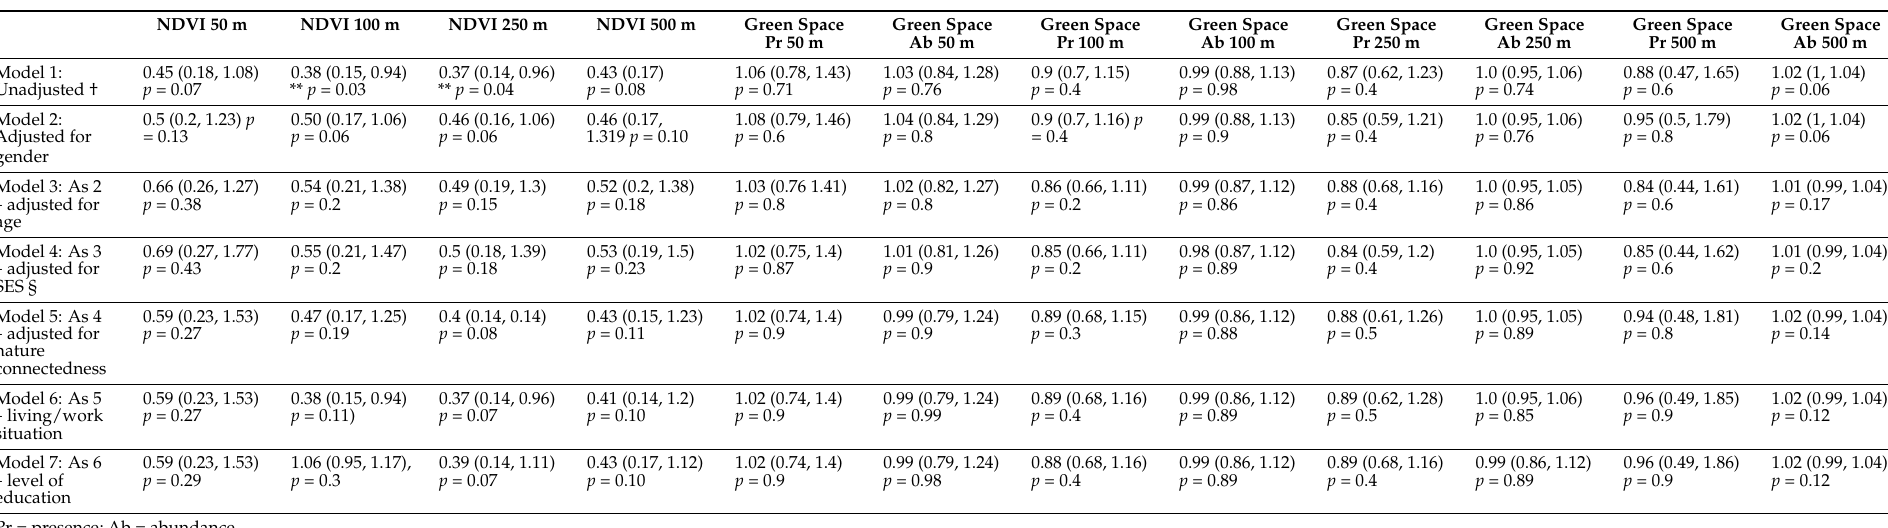
Table 5. Association between NDVI, green space presence and abundance, and perceived stress during the COVID-19